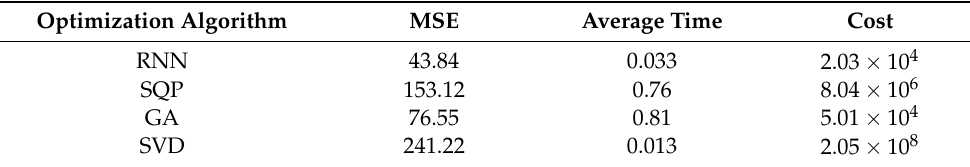
Table 4. A comparison of different optimization algorithms for finding the control signals. Optimization Algorithm